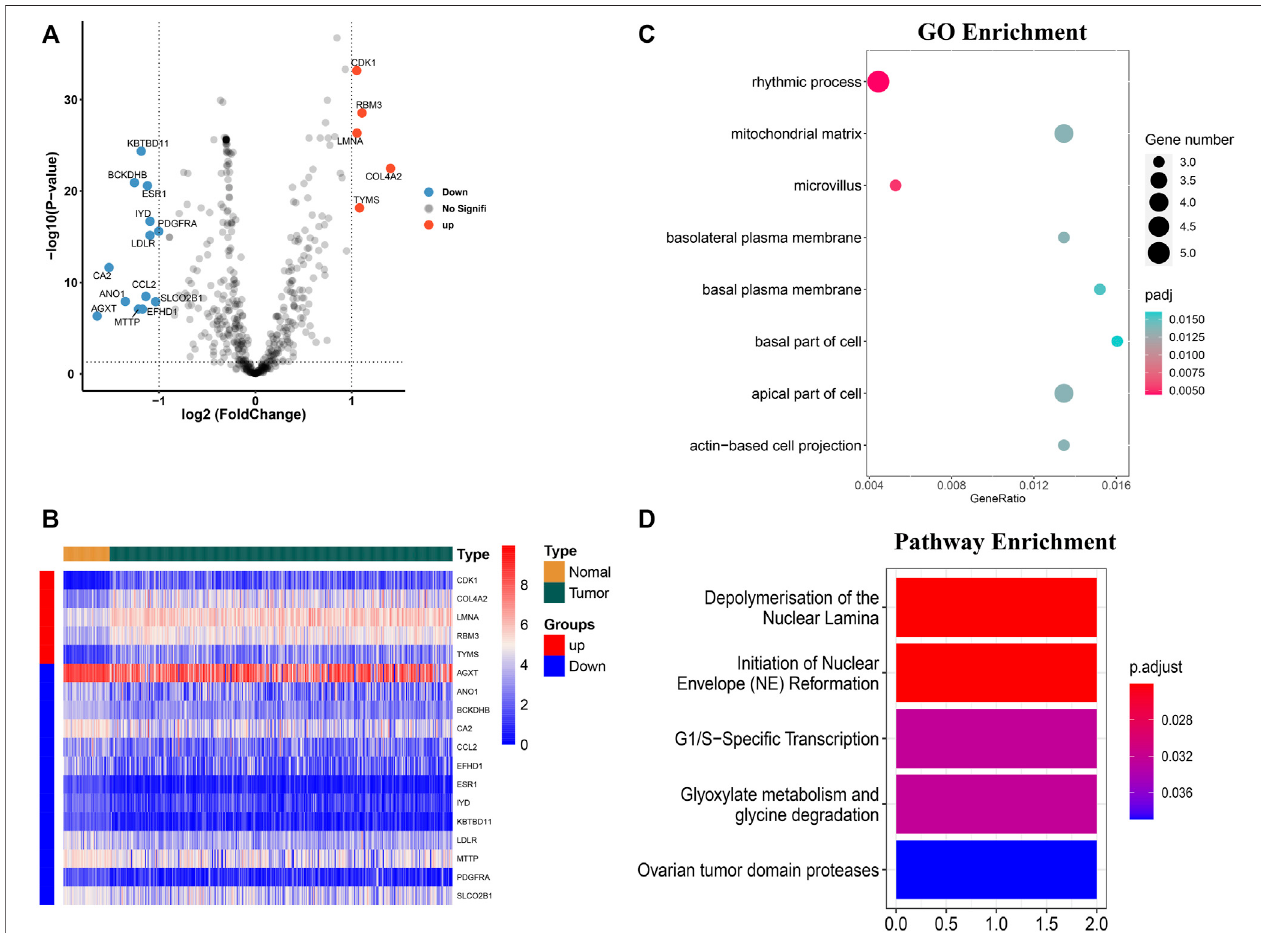
FIGURE1| Identi fi cationofthedifferentiallyexpressedm7G-relatedgenesandfunctionalenrichmentanalysis. (A) Volcanoplotofthedifferentiallyexpressedm7g- related genes. (B) Heatmap of the differentially expressed m7G-related genes. (C) GO functional enrichment analysis. (D) Reactome pathway analysis.